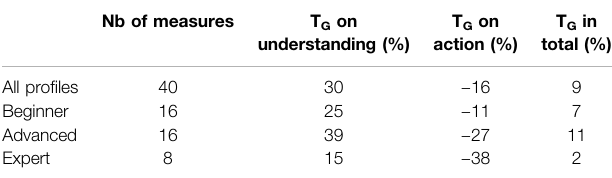
TABLE 3 | Results on time observation per subtask for all pro fi les of